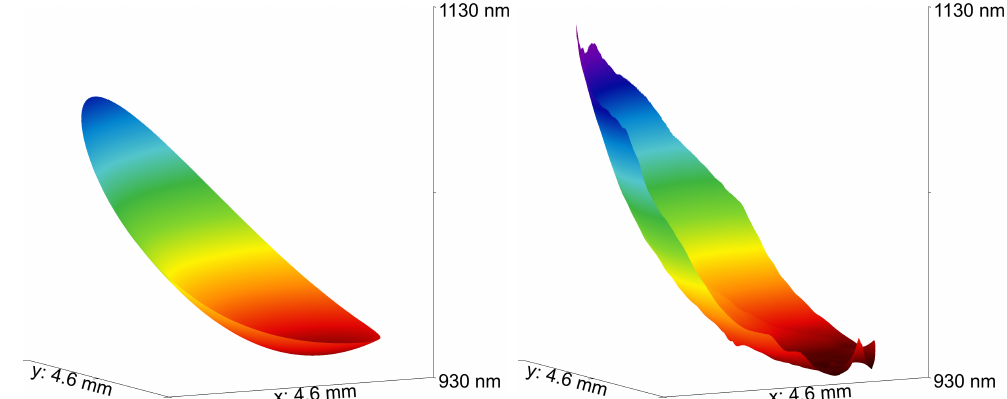
Figure 8. Three-dimensional representations of the shape of the upper boundary determined by the ellipsometric method ( left ) and by ISR ( right ) for the SiO x C y H z film.